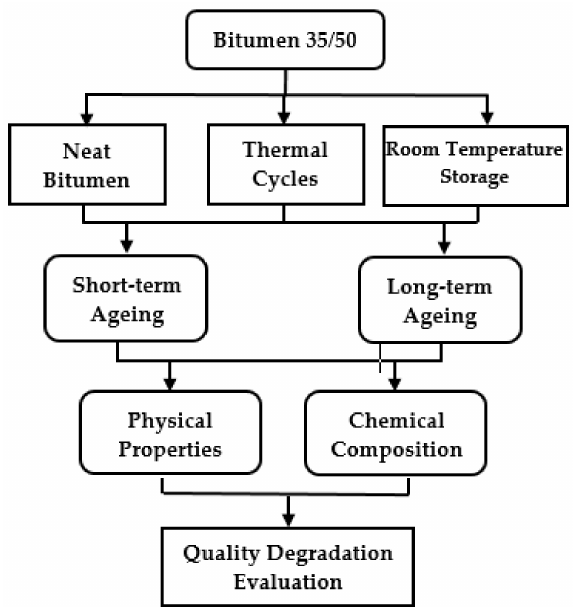
Figure 1. Scheme of the work